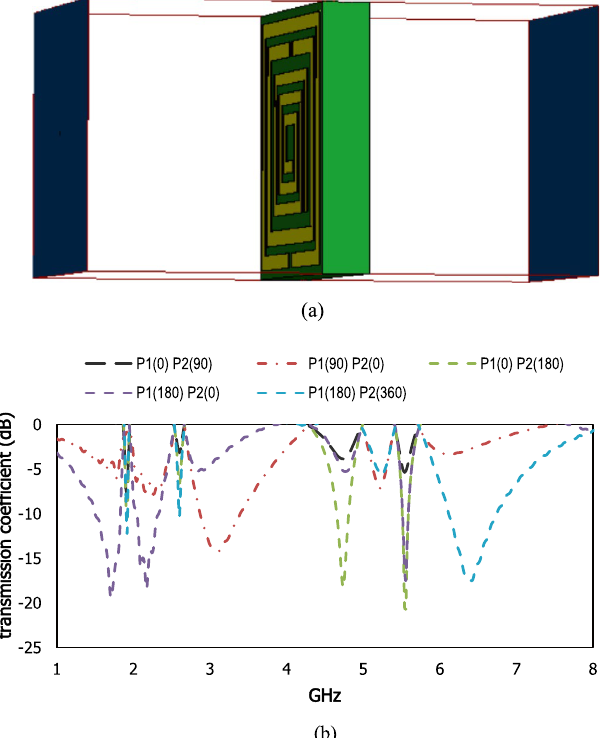
Figure 18. ( a ) Two waveguide ports and ( b ) scattering results for different phase responses in two ports.